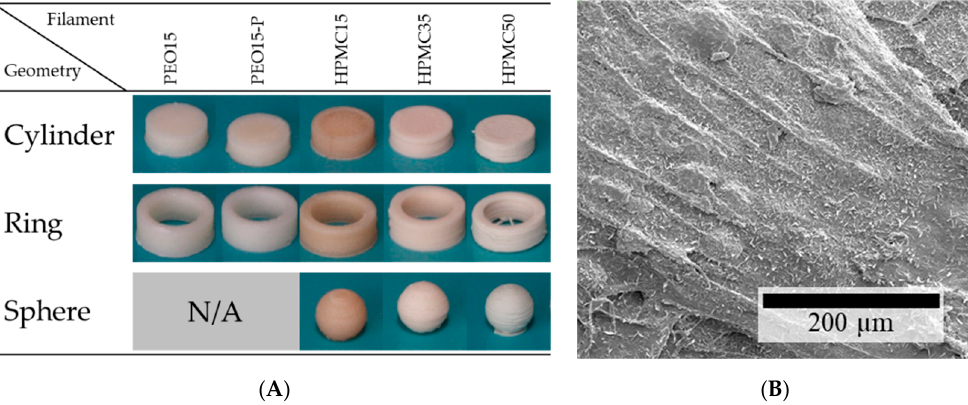
Figure 8. ( A ) Images of 3D-printed theophylline-loaded dosage forms with the same volume; ( B ) SEM image of the surface of a 3D-printed object made from HPMC15 filament.